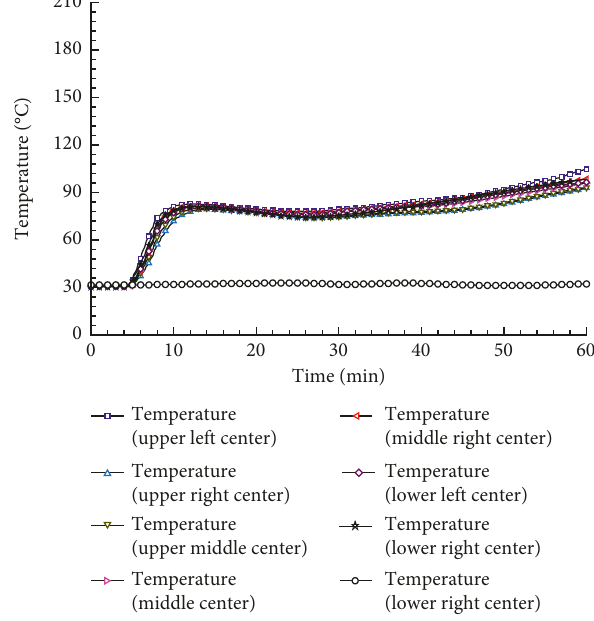
Figure 13: Time-temperature chart for the specimen in Test